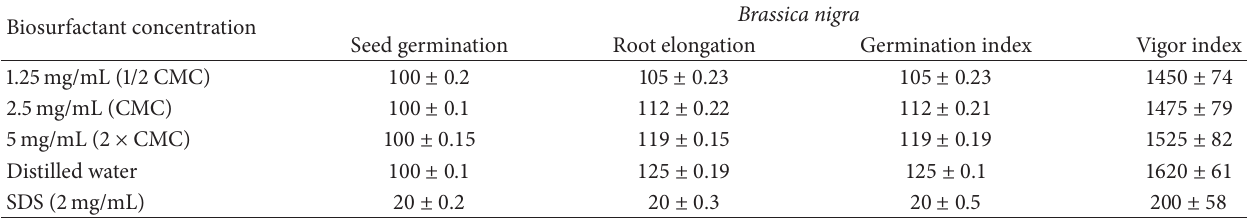
Table 1: Phytotoxicity evaluation of biosurfactant at different concentrations on Brassica nigra . Biosurfactant concentration